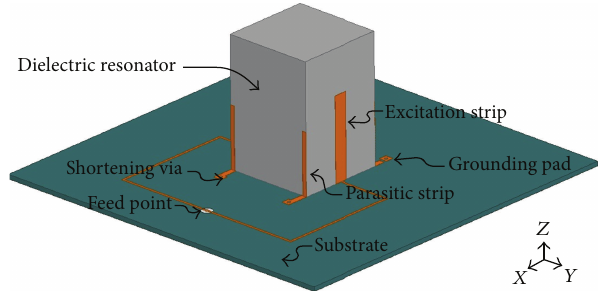
Figure 1: 3D model of proposed DRA structure.